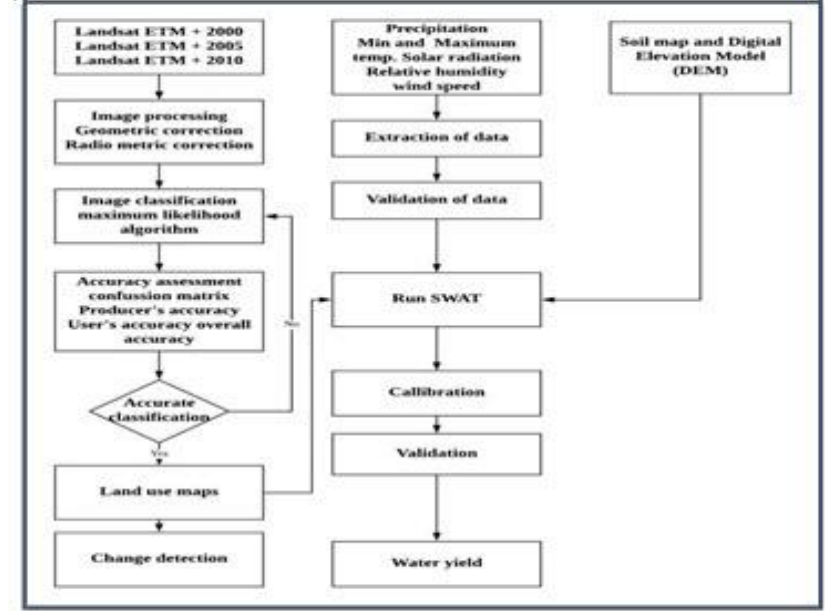
Figure 2. Methodology flow chart